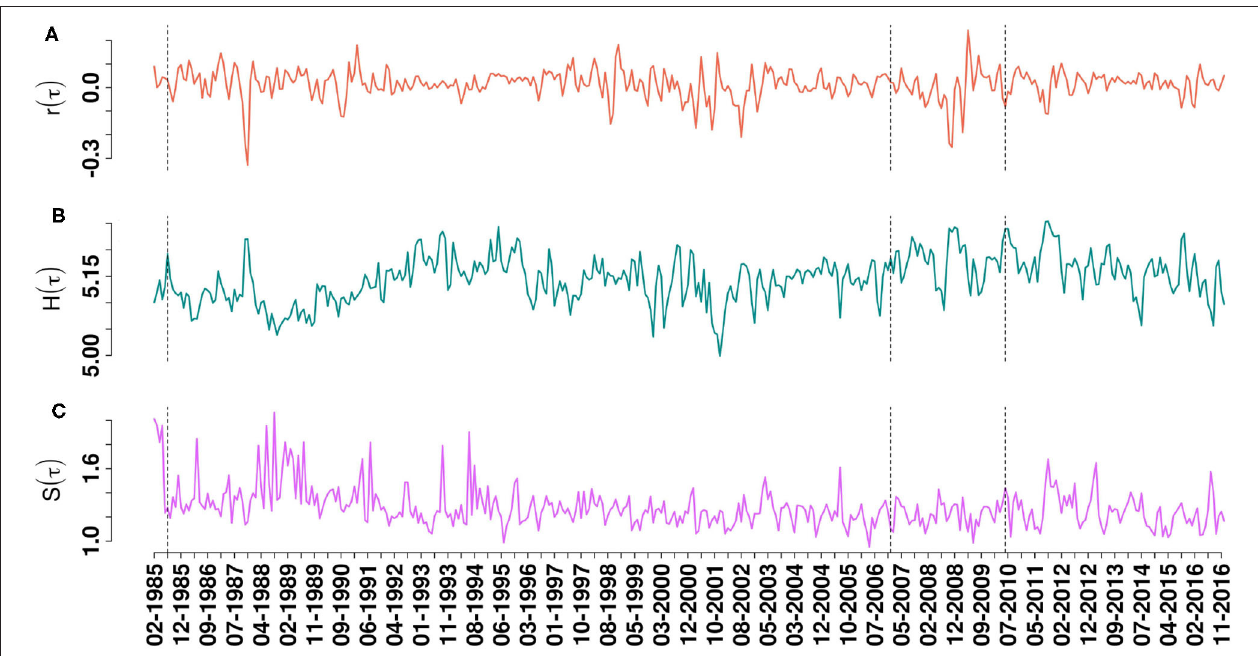
FIGURE 2 | Continuous monitoring of S&P 500 market with 194 stocks and for a rolling time-epoch of 40 days and shift of 20 days over a period of 1985 The logarithmic returns of S&P 500 index is shown in (A) . (B) Shows the temporal evolution of a new measurement “eigen-entropy” H ( τ ), calculated from eigen-vector centralities of correlation matrices. Evolution of structural entropy S ( τ ) calculated by using community detection algorithm is shown in (C) . The dashed vertical lines are corresponding to different periods (normal, bubble, and crash) whose static results are shown in Figure 1